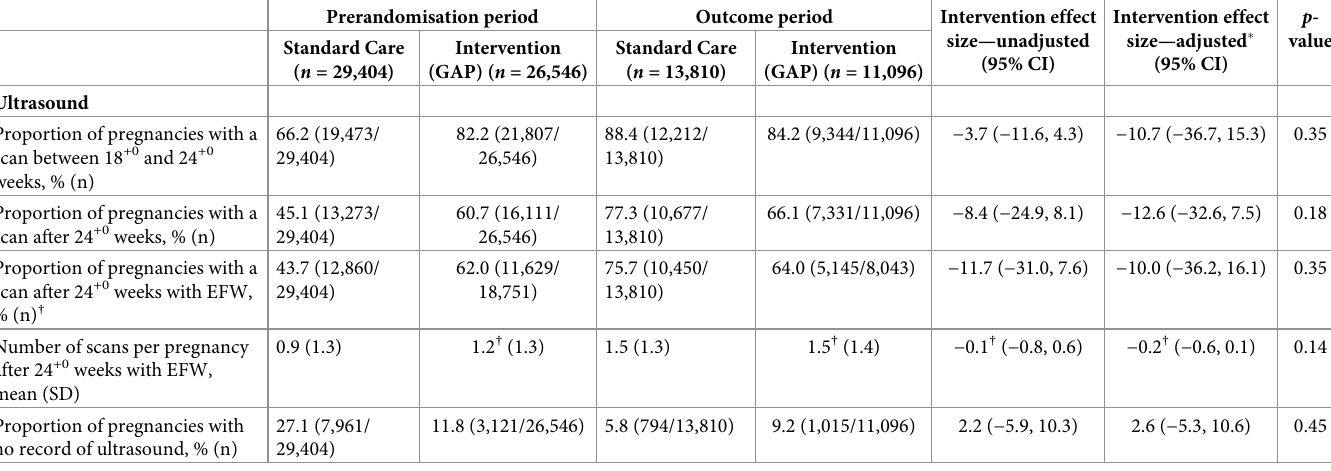
Table 3. Utilisation of ultrasound services according to treatment allocation (mITT analysis).